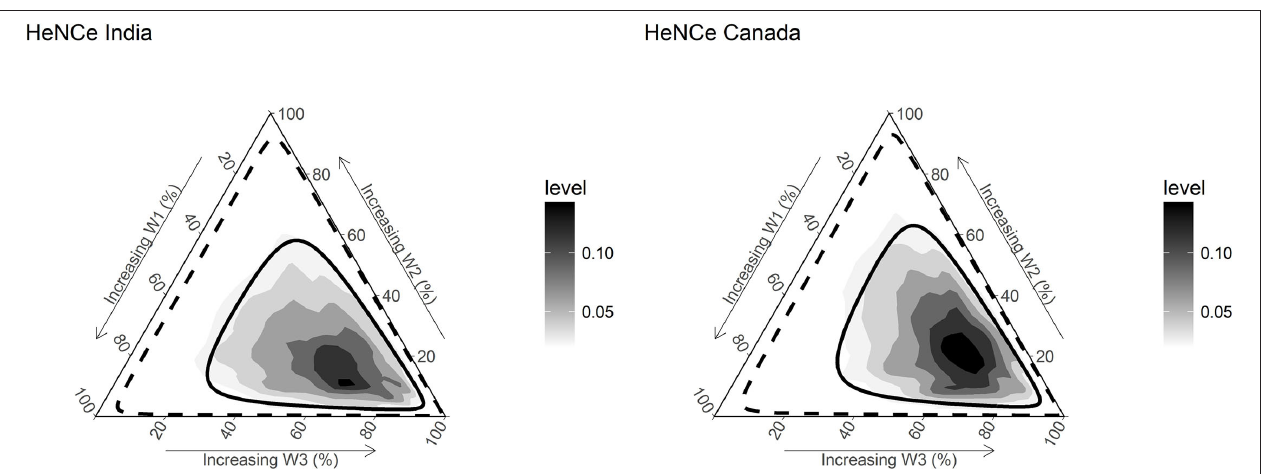
FIGURE 3 | Densities and credible limits of posterior distributions of weights for exposure to tobacco smoking during three time periods [ ≤ 30 years (w1), 31–50 years (w2), and > 50 years (w3)] with regards to risk for developing head and neck cancer (HNC), among human papillomavirus negative (HPV − ve ) participants. Darker areas represent higher densities. The solid line represents the 50% credible limit, and the dashed line represents the 95% credible limit. The posterior distributions have relatively higher density toward the right lower vertices of the ternary plot, suggesting that the weights combinations with a higher value for the weight corresponding to the life period > 50 years have a higher probability compared with others. In turn, the findings support a late-life ( > 50 years) sensitive period